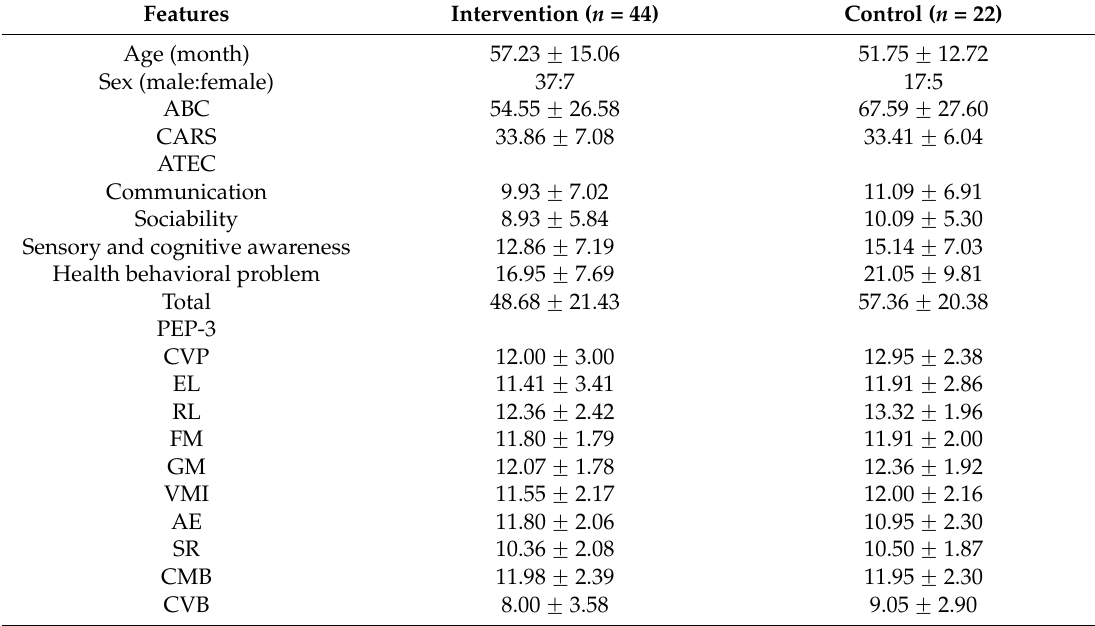
Table 1. Clinical features in the intervention and control groups,